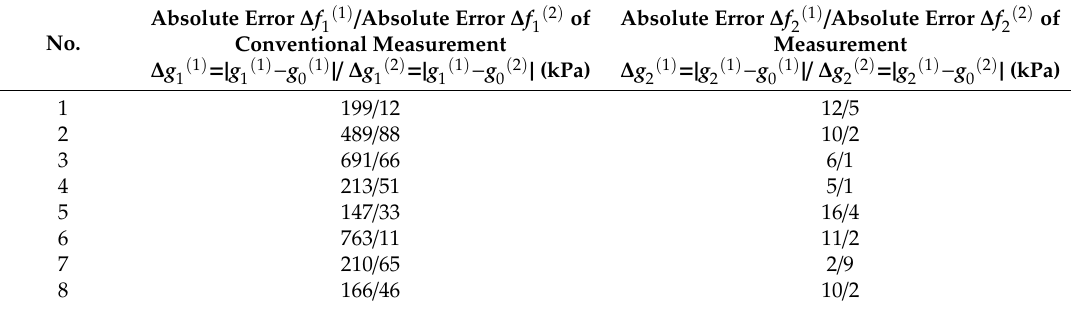
Table 9. Measurement absolute errors of two pointer meters for two